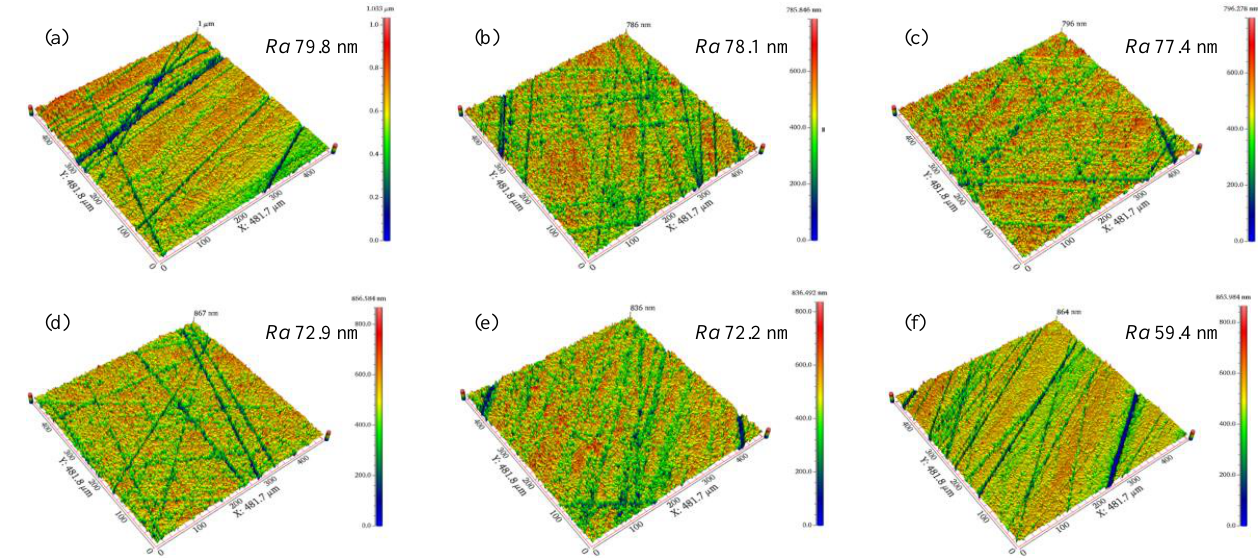
Figure 13. Micrographs and 3D micro-topography images of rake face. ( a ) initial, Ra 79.8 nm, ( b )